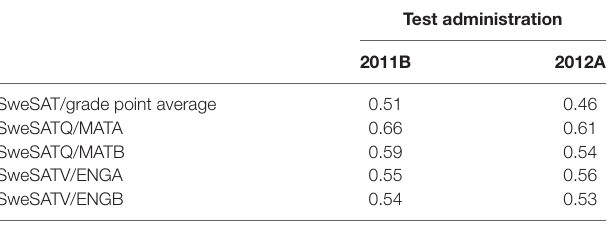
taBlE 1 | Pairwise correlations between Swedish admissions test (SweSAT) scores and grade